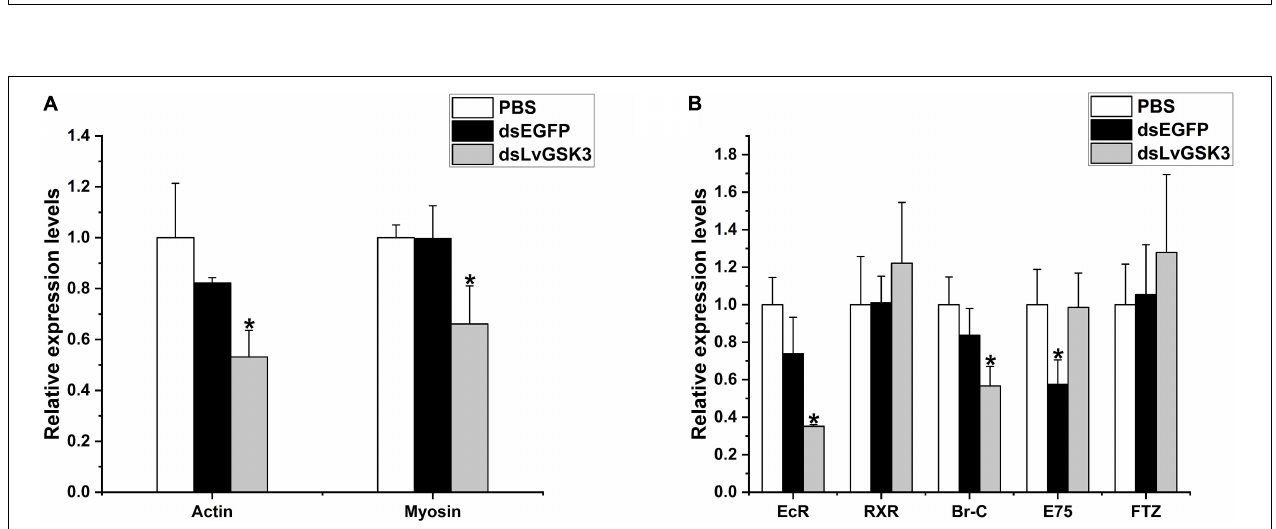
FIGURE 7 | The growth of L. vannamei after LvGSK3 RNAi. (A) The increase in body weight after LvGSK3 RNAi. (B) The increase in body length after LvGSK3 RNAi. (C) The raincloud figure reflected the increase in body weight after LvGSK3 RNAi. (D) The raincloud figure reflected the increase in body length after LvGSK3 RNAi. The results were based on three independent biological replicates and are shown as mean values ± SD. Significant differences of the gene expression levels between three treatments are shown as * p < 0.05.